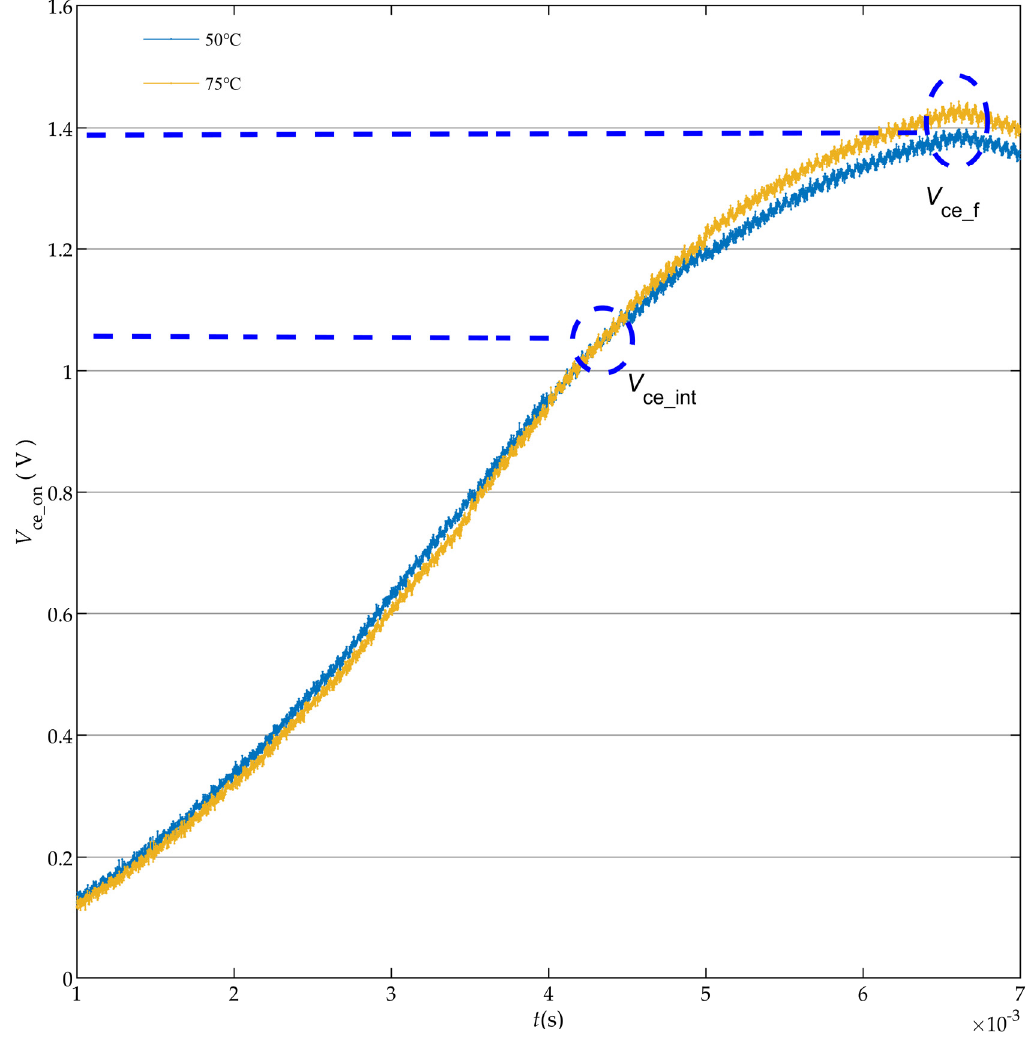
Figure 8. Online monitoring results with different junction temperatures.